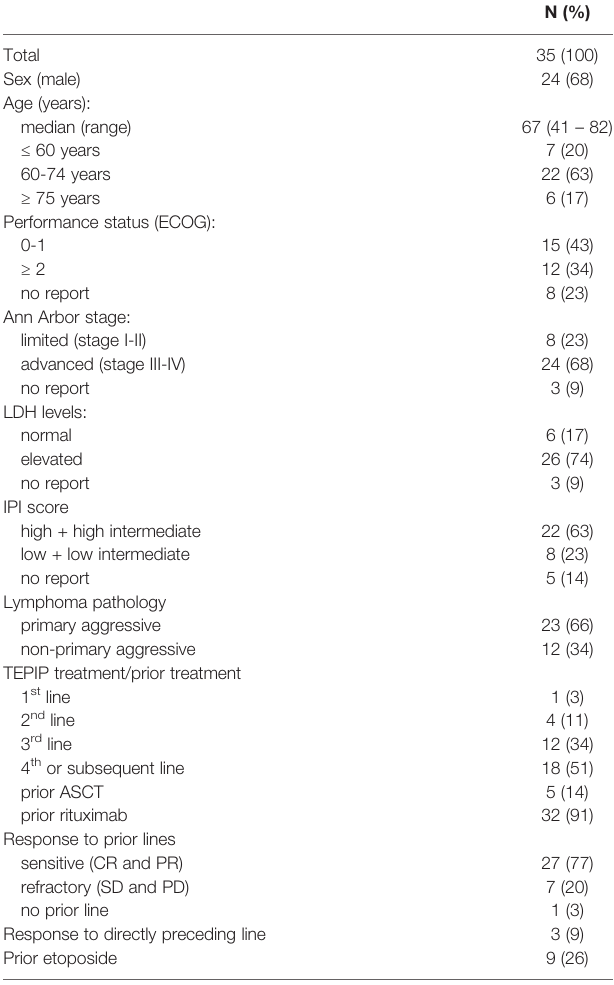
TABLE 1 | Patient characteristics at the initiation of TEPIP